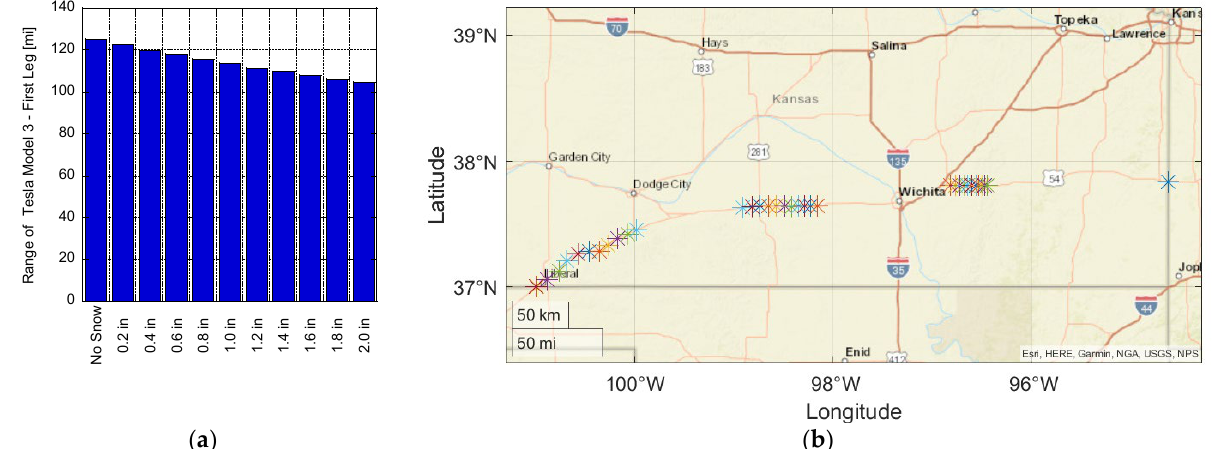
Figure 17. ( a ) Range of Tesla Model 3 in July 2020 heading East on US-54 as a function of rain on road. ( b ) Stopping locations indicated by the symbols * based on rain level with sooner stops needed heading out of Liberal, KS. Vehicle mileage = 1000 miles, HVAC system on.